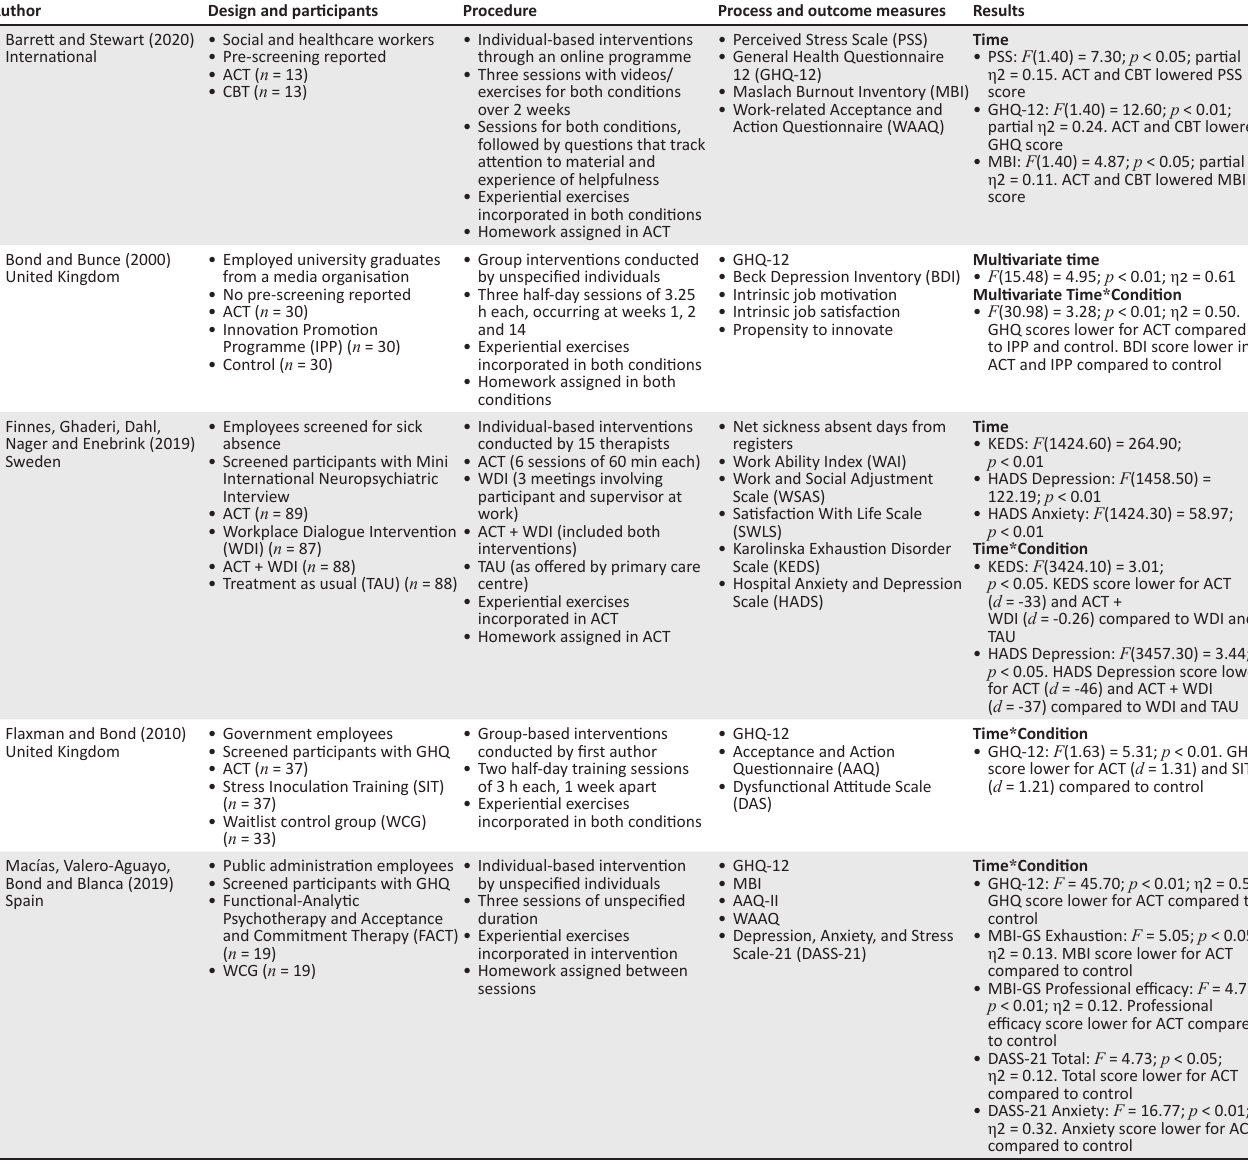
TABLE 2: Acceptance and commitment therapy as a work-based counselling